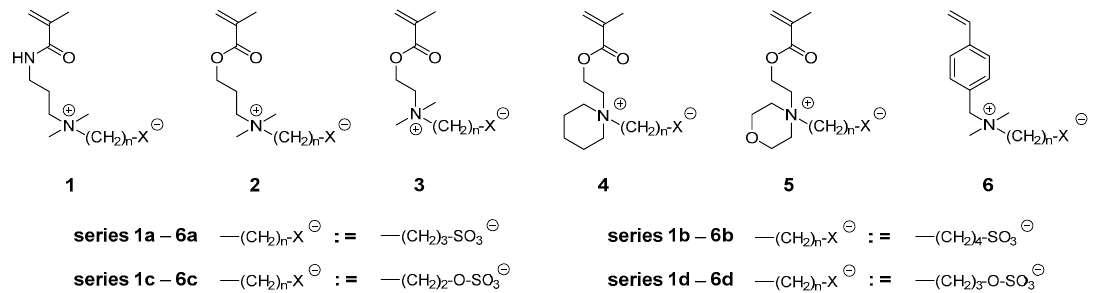
Figure 1. Examples of zwitterionic methacrylic and styrenic sulfobetaine (series a–b) and sulfabetaine (series c–d) monomers studied: Series a = 3-ammonio propanesulfonates, series b = 4-ammonio